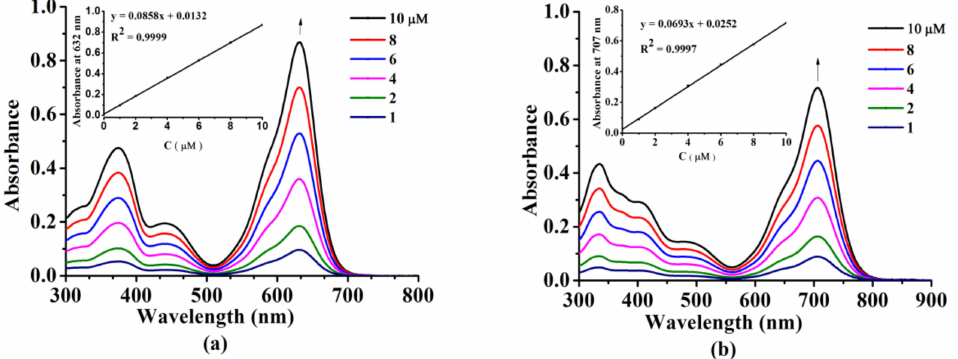
Figure 2. Electronic absorption spectra of compounds 6 ( a ) and 7 ( b ) at different concentrations in DMSO. The inset plots the Q-band absorbance versus the concentration of